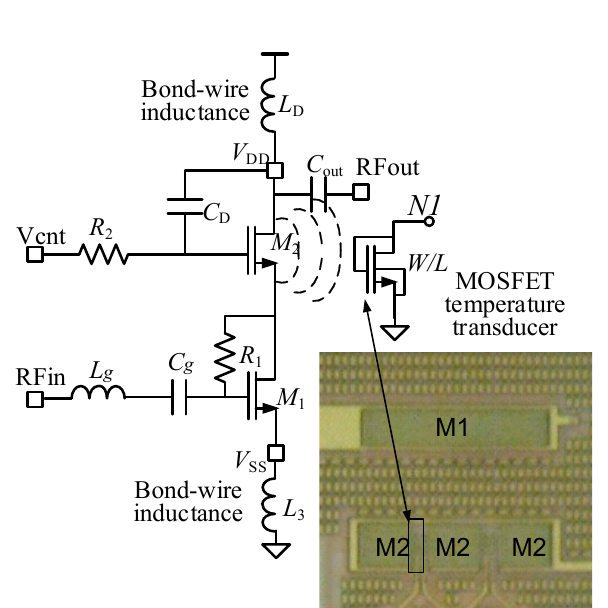
Figure 10. Schematic of the RF power amplifier used as CUT. The temperature transducer is placed close the cascode transistor M2. Inset shows a photo of the IC layout, with the placement of the active transistor M1, cascode transistor M2 (formed with three equal transistors connected in parallel), and the MOS acting as temperature transducer.